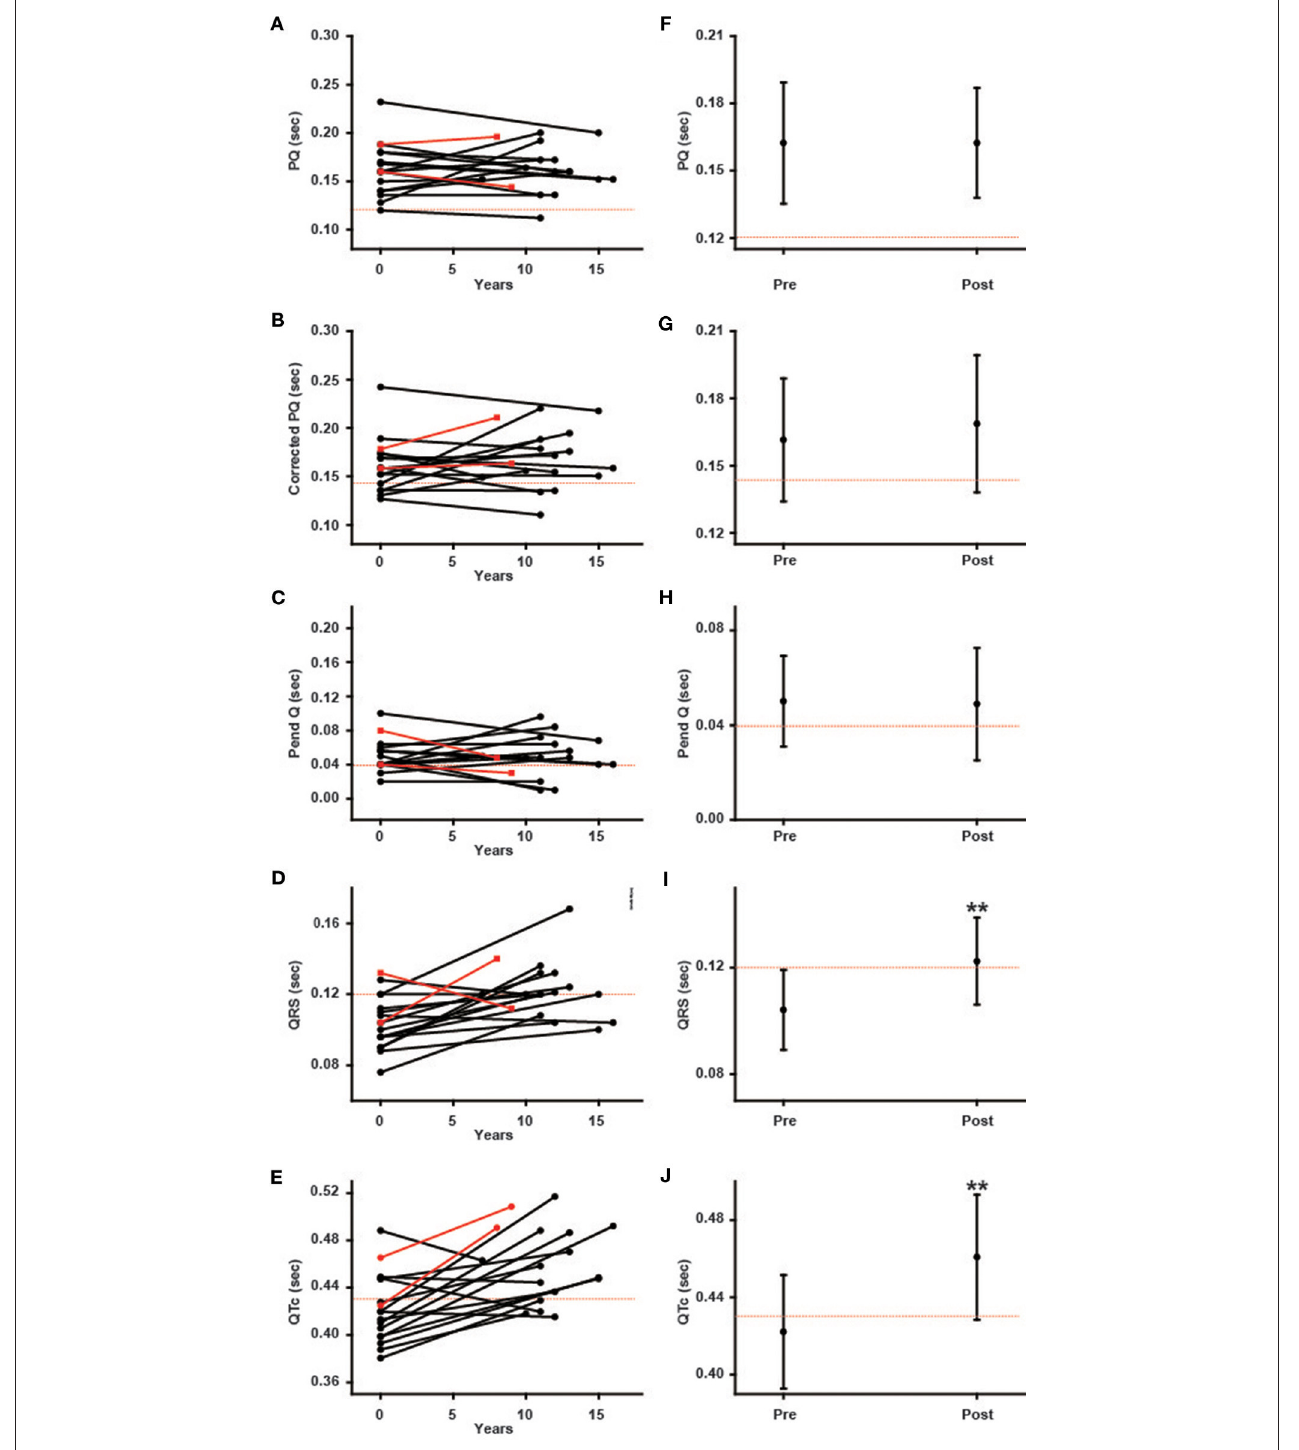
FIGURE 3 | Changes in various ECG parameters during long-term enzyme replacement therapy in male patients. In the left columns, each line indicates the time-dependent changes in ECG parameters in each patient (A–E) . The black lines show the patients with the classical type, and the red lines show the patients with the late-onset type. The right columns show the average values of ECG parameters before (Pre) and after (Post) long-term enzyme replacement therapy (F–J) . The dotted lines indicate the cut-off value for abnormalities in each parameter. Corrected PQ, PQ interval divided by the square root of RR interval; Pend-Q, PQ interval minus P-wave duration in lead II; QTc, QT interval divided by the square root of RR interval. ** p < 0.01 comparison between before (Pre) and after (Post) enzyme replacement therapy.